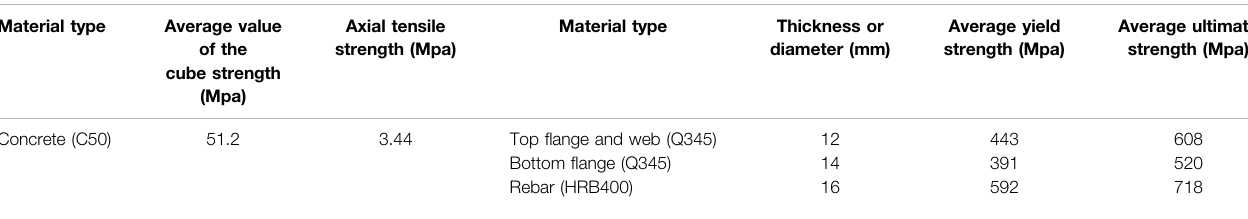
TABLE 1 | Material properties of the specimen